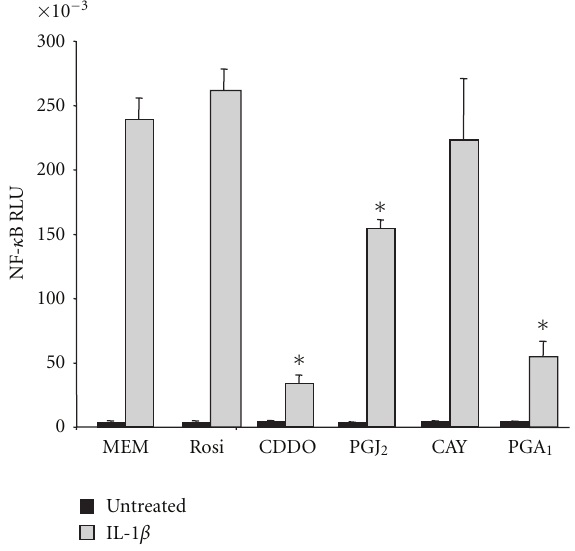
Figure 8: CDDO and PGA 1 inhibit IL-1 β -induced NF- κ B tran- scriptional activity in human lung fibroblasts. Primary human lung fibroblasts were transfected with a luciferase reporter, then pretreated with 20 μ M rosiglitazone (Rosi), 1 μ M CDDO, 5 μ M 15d-PGJ 2 (PGJ 2 ), 5 μ M CAY10410 (CAY), or 15 μ M PGA 1 and cotreated with of IL-1 β for 24 hours as described. NF- κ B-dependent luciferase activity was measured in lysates as described, normalized to protein concentration, and expressed as relative light units (RLU). NF- κ B activation is significantly reduced in PPAR γ ligand- treated fibroblasts compared to IL-1 β alone ( ∗ P < . 01). Results are mean ± standard deviation for quadruplicate wells and are representative of 2 independent experiments that yielded similar